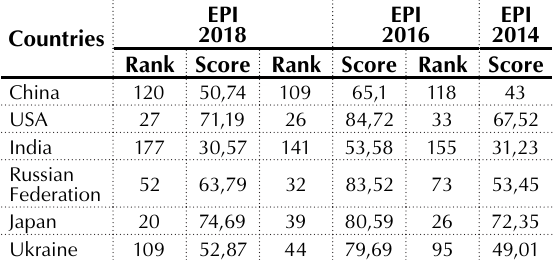
Table 5. The dynamics of EPI